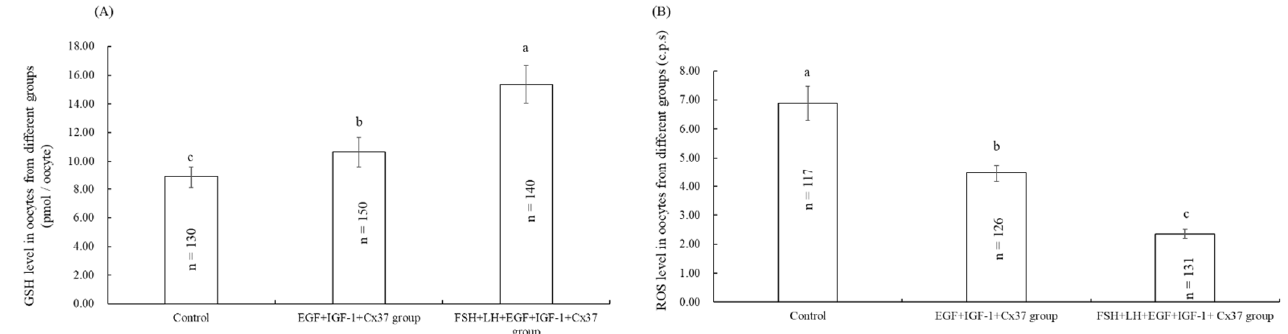
Figure 2. Effect of the combination treatment of EGF, IGF-1, and Cx37 on GSH and ROS level in bovine oocytes. ( A ) Effect of the combination treatment of EGF, IGF-1, and Cx37 on GSH level in bovine oocytes. ( B ) Effect of the combination treatment of EGF, IGF-1, and Cx37 on ROS level in bovine oocytes. a, b, c Values with different superscripts indicate significant differences between groups ( p < 0.05).